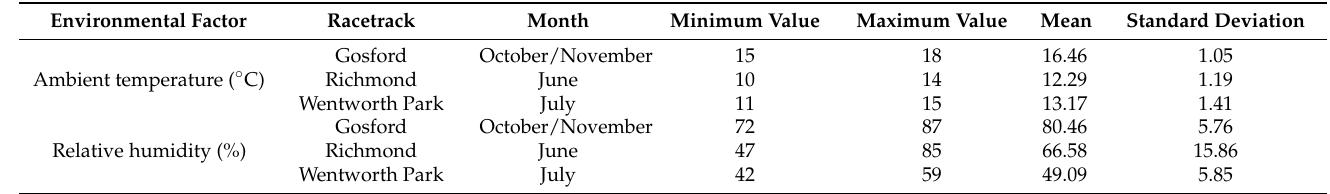
Table 3. The minimum value, maximum value, mean and standard deviation of ambient temperature and relative humidity at each